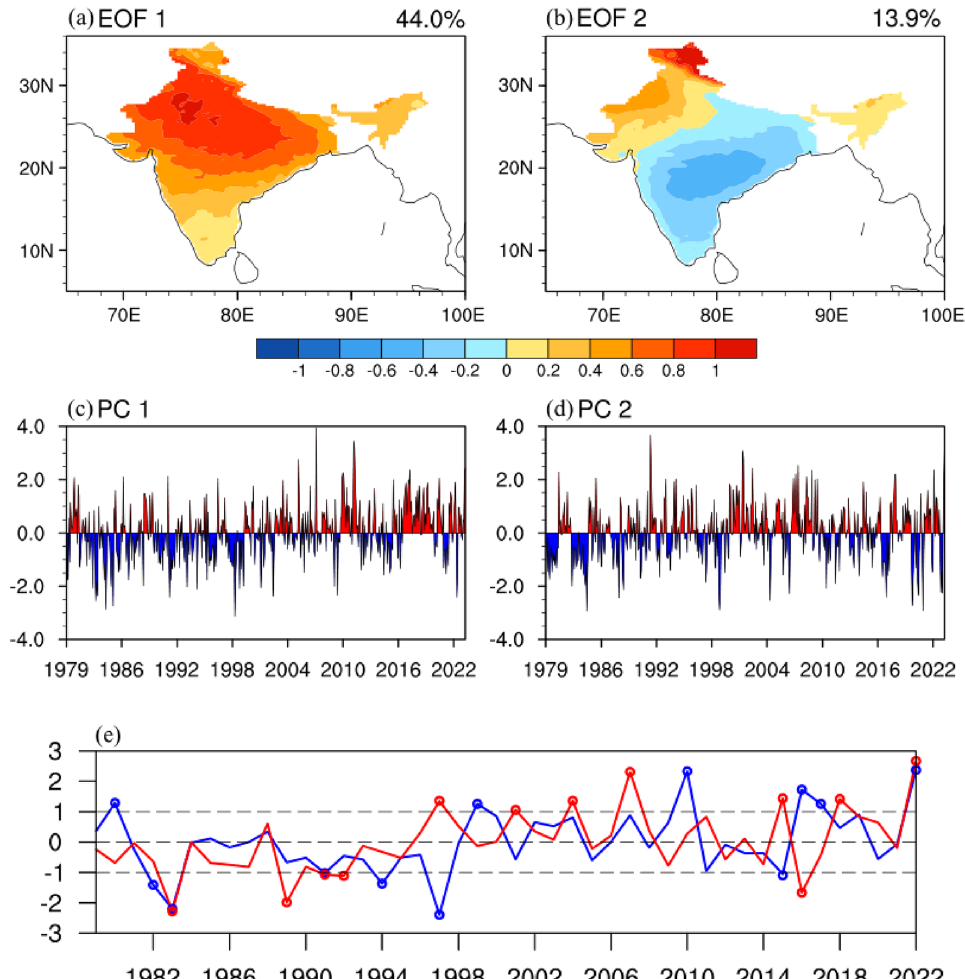
Fig. 2 Spatial patterns of a EOF1 and b EOF2 of the monthly SAT anomalies (°C) over Indian continent for the period of 1979–2022 (after removing the monthly mean regional average SAT). c and d Are the normalized time series of PCs. e The normalized time series of PC1 (red line) and PC2 (blue line) during April from 1979 to 2022. The pronounced EOFs cases are labeled with